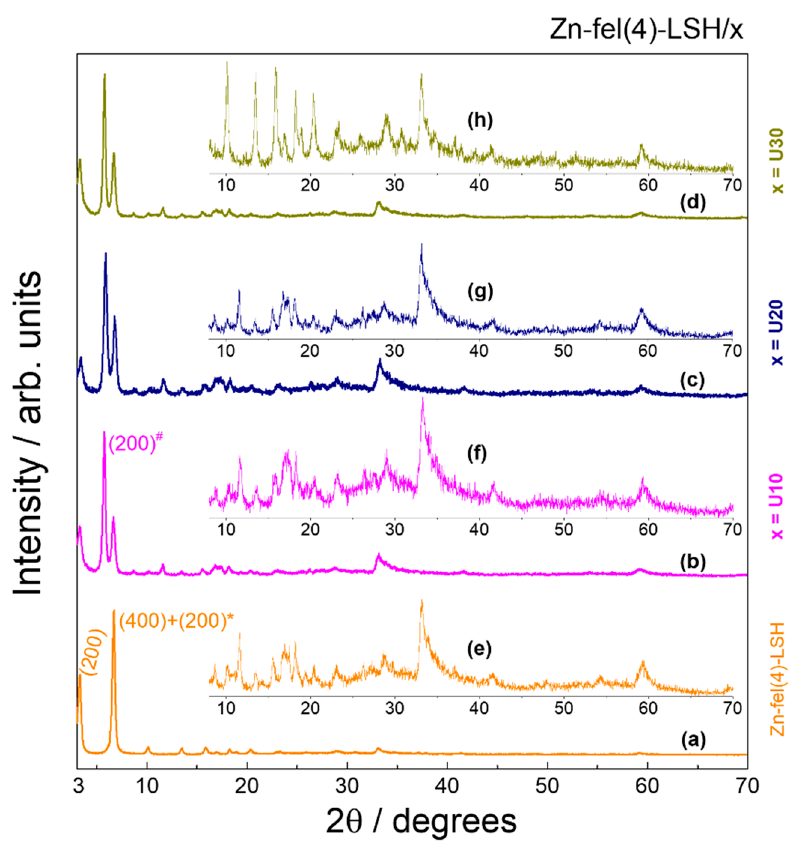
Figure 2. XRD patterns of ( a ) Zn-fel(4)-LSH, ( b ) Zn-fel(4)-LSH/U10, ( c ) Zn-fel(4)-LSH/U20, and ( d ) Zn-fel(4)-LSH/U30 in the 3 − 70°/2 θ region. Figures inserted show magnified X-ray diffrac- tion lines of ( e ) Zn-fel(4)-LSH, ( f ) Zn-fel(4)-LSH/U10, ( g ) Zn-fel(4)-LSH/U20, and ( h ) Zn-fel(4)- LSH/U30 in the 8 − 70°/2 θ region. Table 1. Interplanar distance d 200 , basal distance, and interlayer spacing of LSH materials.